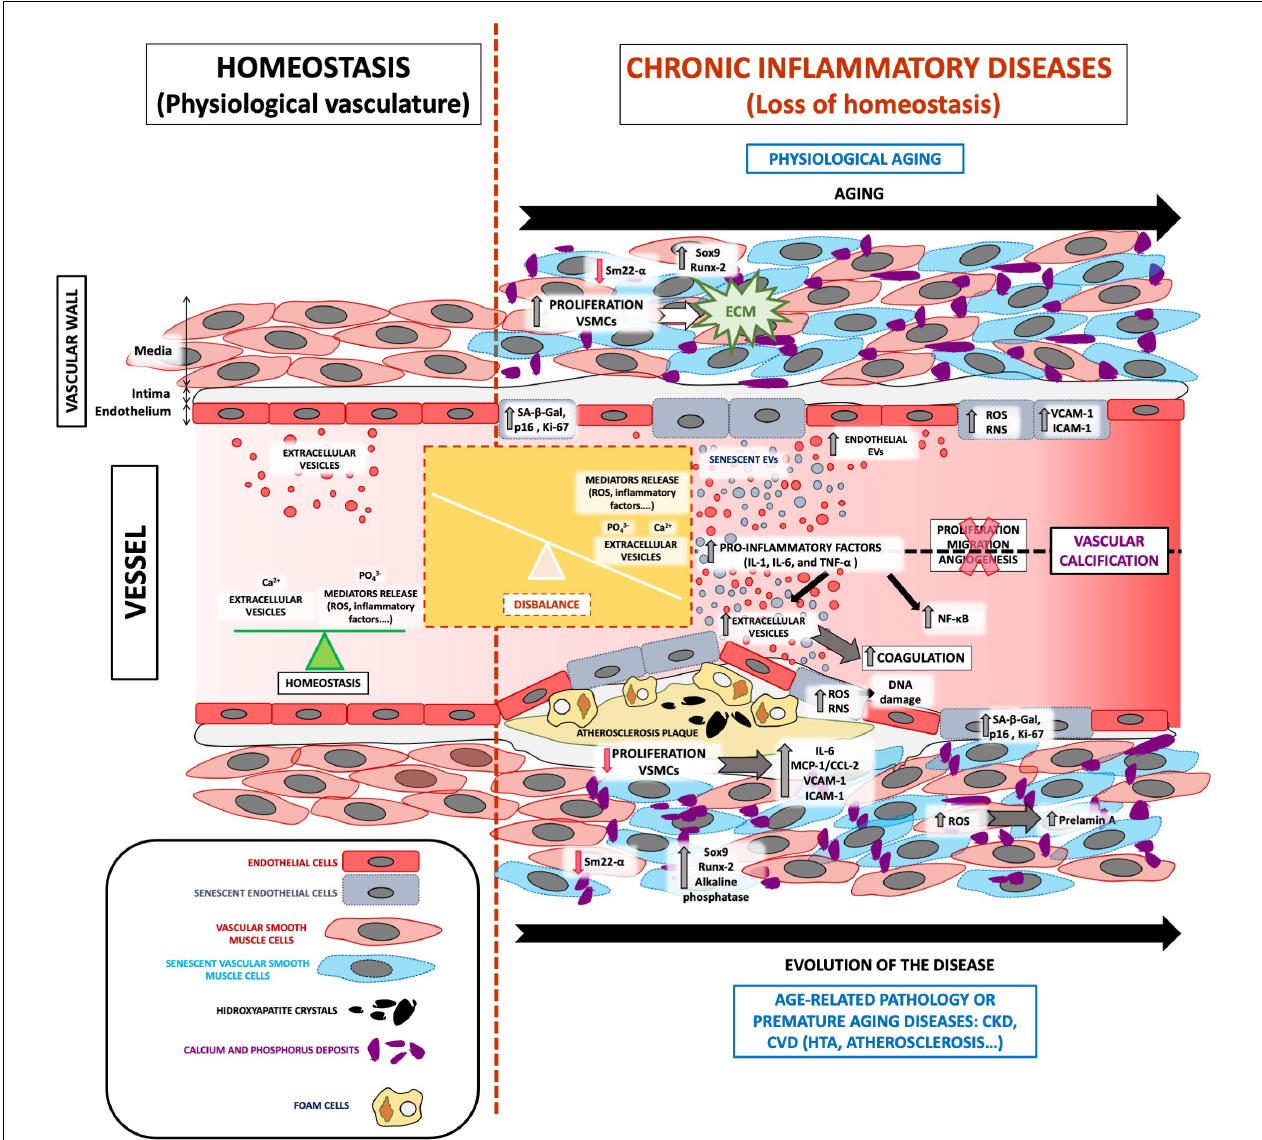
FIGURE 1 | The role of EVs in VC development associated with vascular senescence. Under physiological conditions, the vasculature presents a balance between oxidative stress, inflammatory factors, and calcium and phosphate release and highlights the regular release of extracellular vesicles. All these mediators are focused on maintaining vessel homeostasis. The loss of homeostasis could appear with physiological aging and age-related pathologies such as CKD and/or CVD, which implies the imbalance of several processes. Both physiological and premature aging illnesses are characterized by an increase in ROS, calcium, and phosphate release, inflammatory mediators, adhesion molecules, coagulation process, the proliferation of extracellular matrix proliferation in the blood, and especially increased vasculature senescence. In addition, cells from a senescent vessel, especially endothelial cells and vascular smooth muscle cells, release extracellular vesicles that contain calcification factors. Complex signaling pathways in senescent extracellular vesicles cause spontaneous calcium ion precipitation in the arteries and thus contribute to VC development and